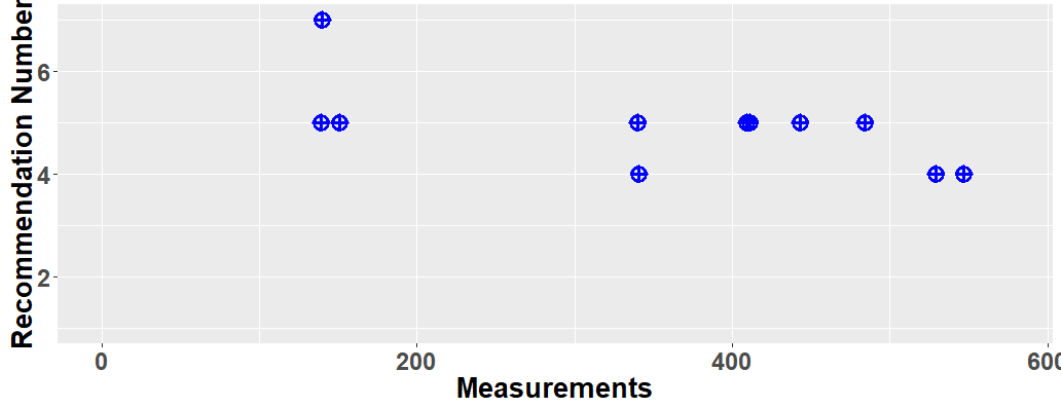
Figure 9. Driving recommendation timeline for the studied trip respecting Table 3′s seven rules.